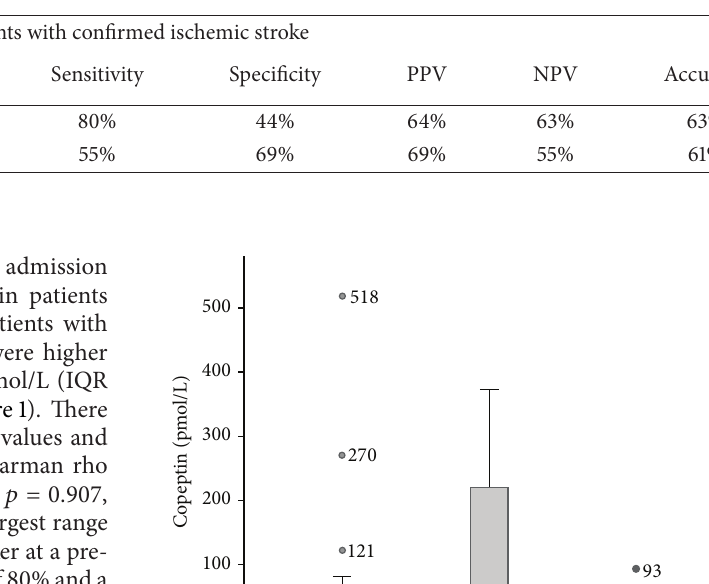
Table 2: Ischemic stroke diagnostic performance of Copeptin at different cut-offs.